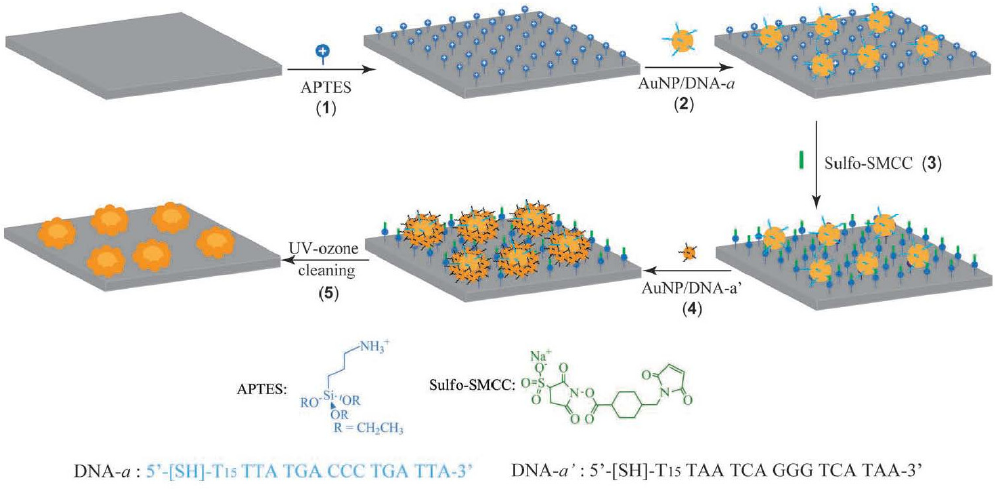
Figure 6. Schematic presentation for the fabrication of core-satellite near-IR SERS sensor (Reprinted with permission from [159], published by WILEY-VCH Verlag GmbH & Co., 2012).